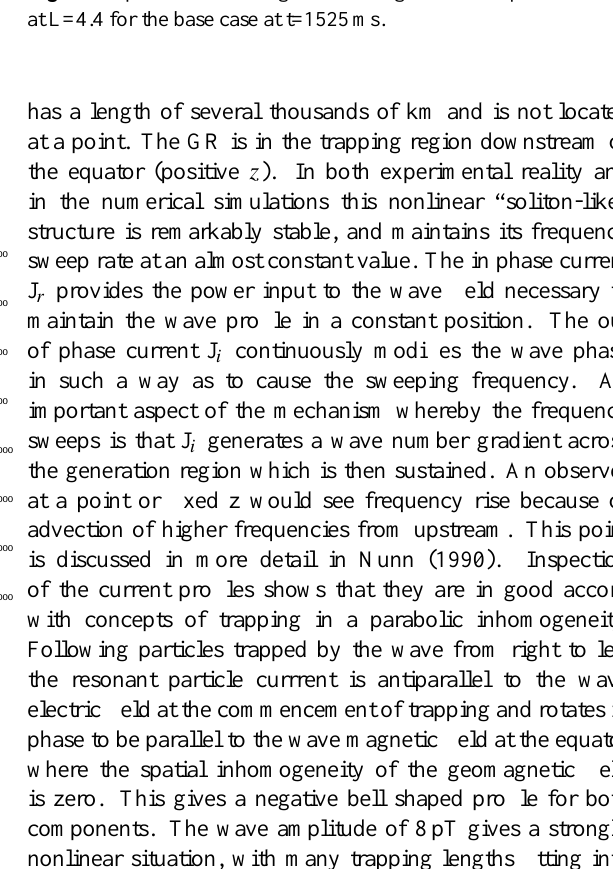
Fig. 3. Snapshot of the riser generation region in the equatorial zone at L=4.4 for the base case at